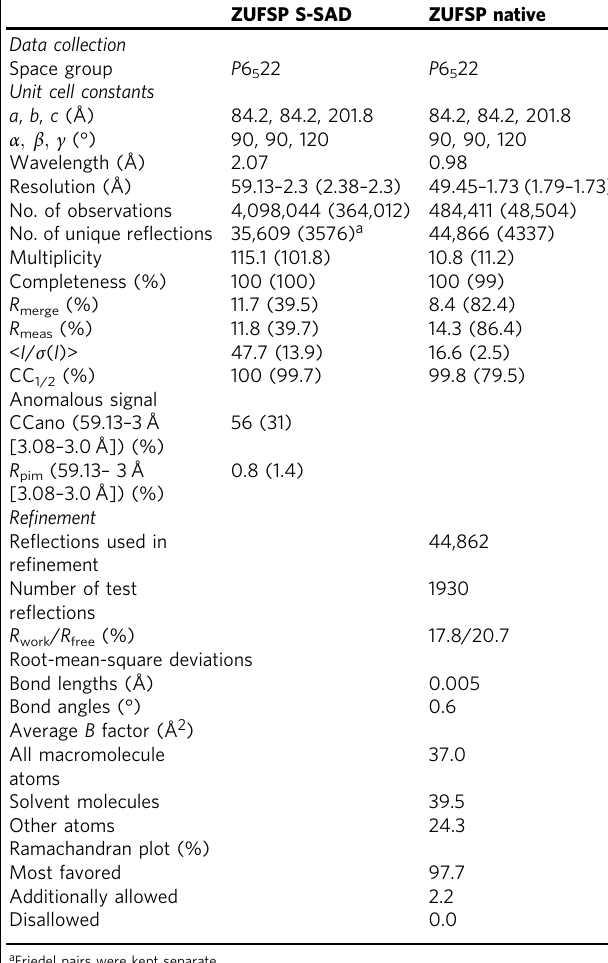
Table 1 Data collection and re fi nement